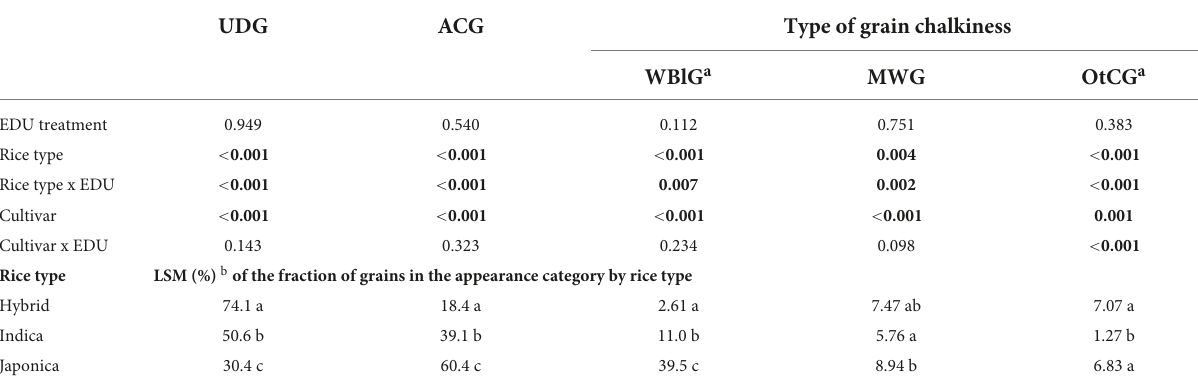
TABLE 1 Effects of ethylenediurea (EDU) application on the grain appearance traits (UDG, undamaged grains; ACG, aggregated chalky grains; WBlG, white-belly grains; MWG, milky-white grains; OtCG, other types of chalky grains consisting of white-back, white-base and white-core grains) in interaction with the rice type and